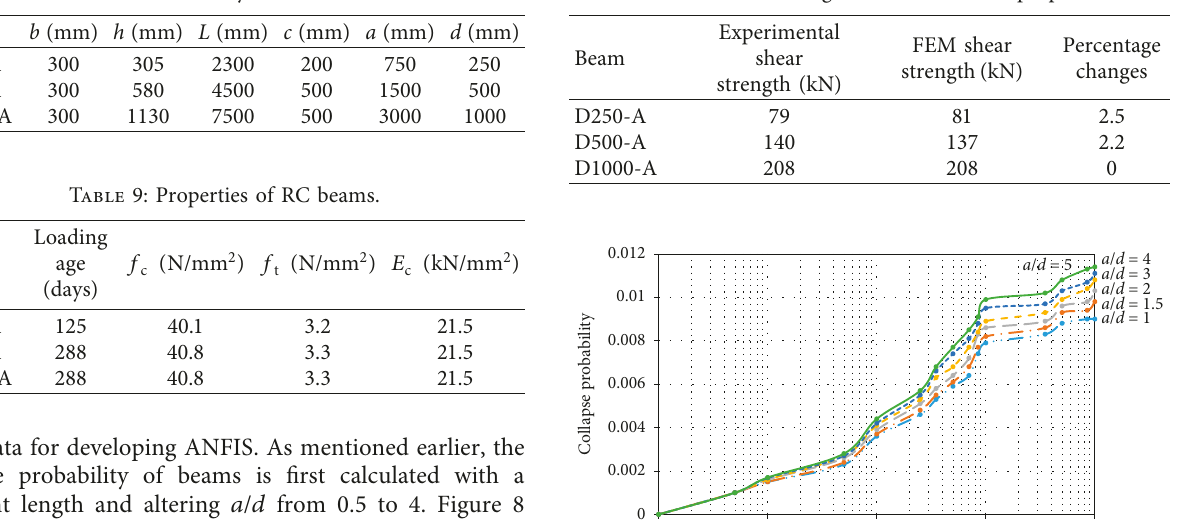
Figure 7: Exceedance probability of beam deflection at load levels of (a) P 40% the beam strength and L /240 limitation, (b) P 40% the (cid:29) (cid:29) beam strength and L /500 limitation, (c) P 40% the beam strength and L /600 limitation, and (d) P 70% the beam strength and L /600 (cid:29) (cid:29) limitation. Table 8: Geometry of RC beams. Table 10: Outline of loading test results and the proposed model.